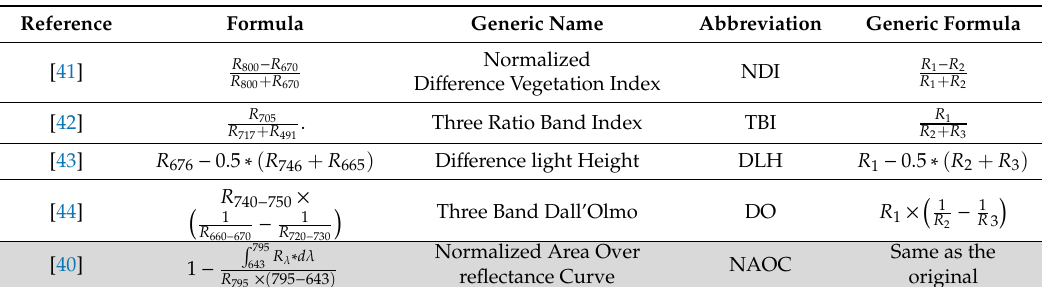
Table 3. Generic vegetation indices that were introduced in ARTMO, related to biophysical parameters. R λ represents the reflectance and λ the wavelength. The generic name of each index has been established in this